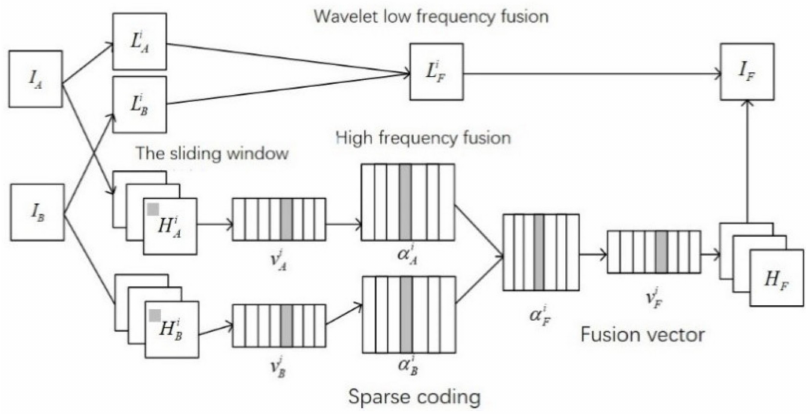
Figure 2. Flow chart of image fusion based on multiscale sparse